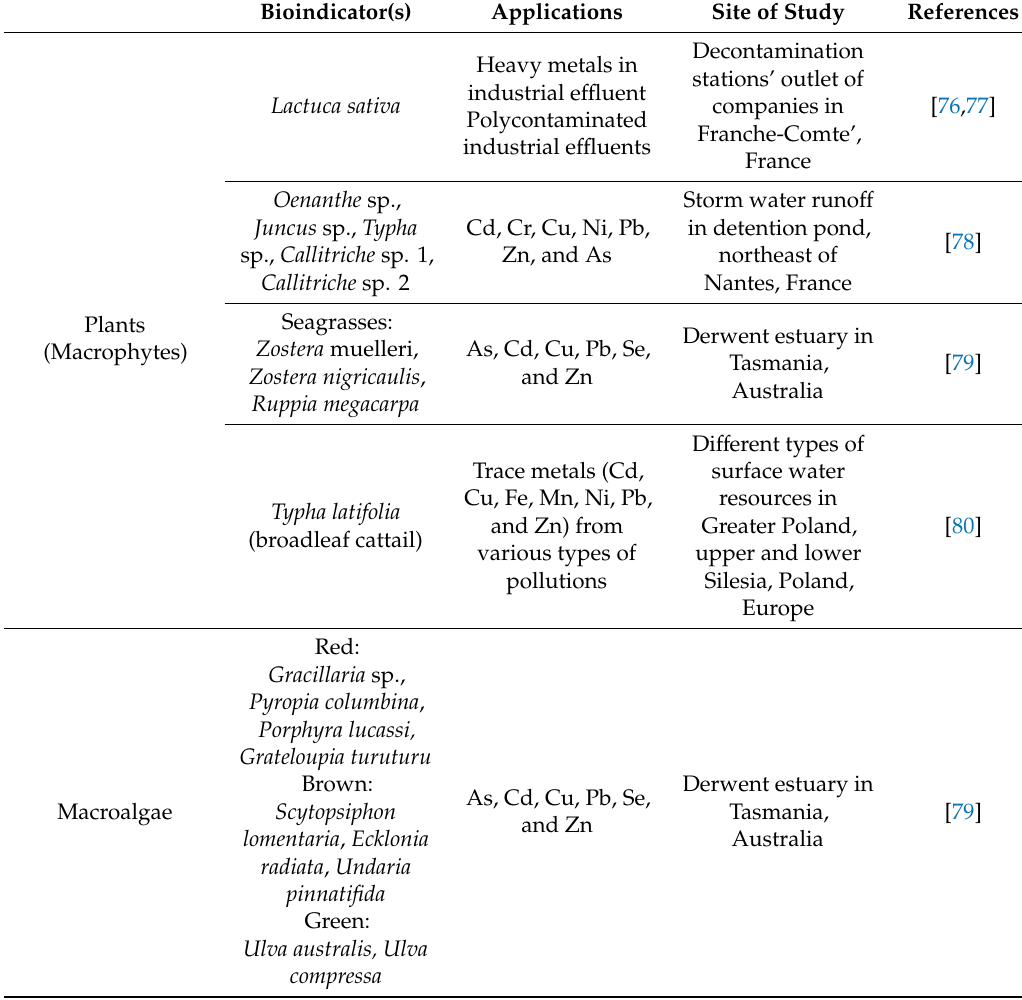
Table 3. Biomonitoring applications in aquatic